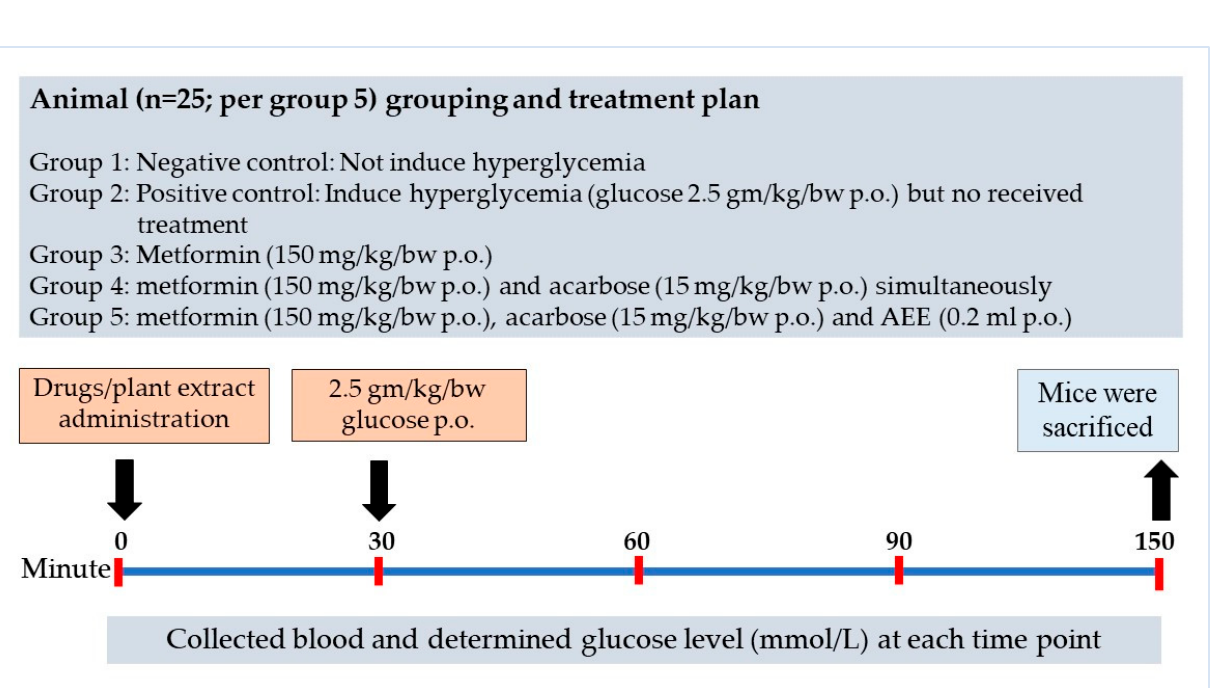
Figure 2. Animal experimental design and treatment regime. p.o.: Per os.